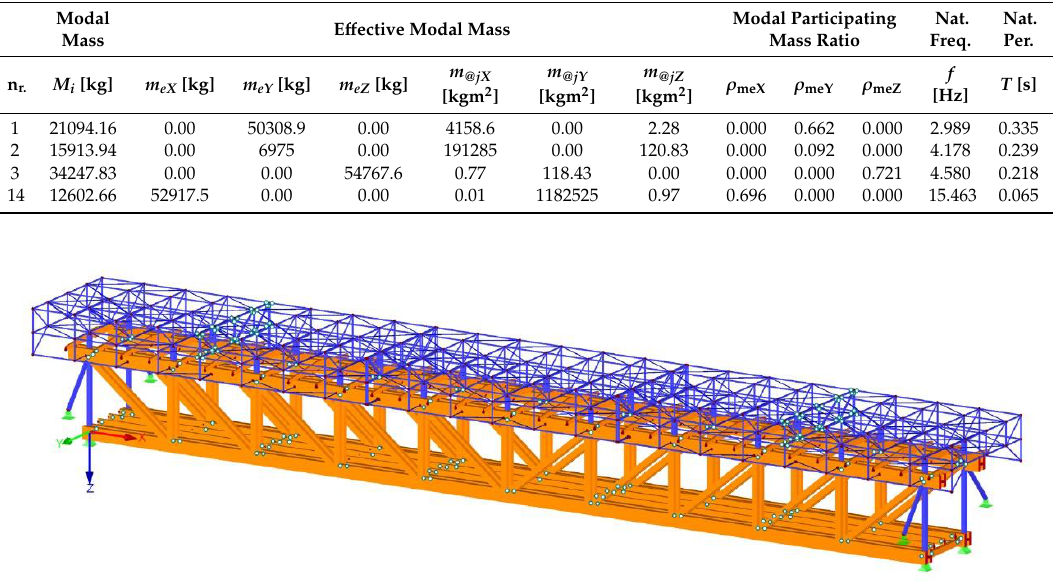
( c ) Figure 10. Cross-section of the torsional modal shape: ( a ) original model (2nd mode of vibration, T =0.239 s; m @jX = 191285.51 kg . m 2 ); ( b ) after the first model update (3rd mode of vibration, T = 0.197 s; m @jX = 466015.09 kg . m 2 ); ( c ) after the second model update (3rd mode of vibration, T = 0.17 s; m @jX = 421632.16 kg . m 2 ). In order to avoid such a deformed configuration, lateral steel tension rods were added on both sides of the bridge along the entire span, thereby conferring stability to the horizontal section (Figures 10b and 11). The results of the modal analysis of the new model are reported in Table 3; Figure 10b